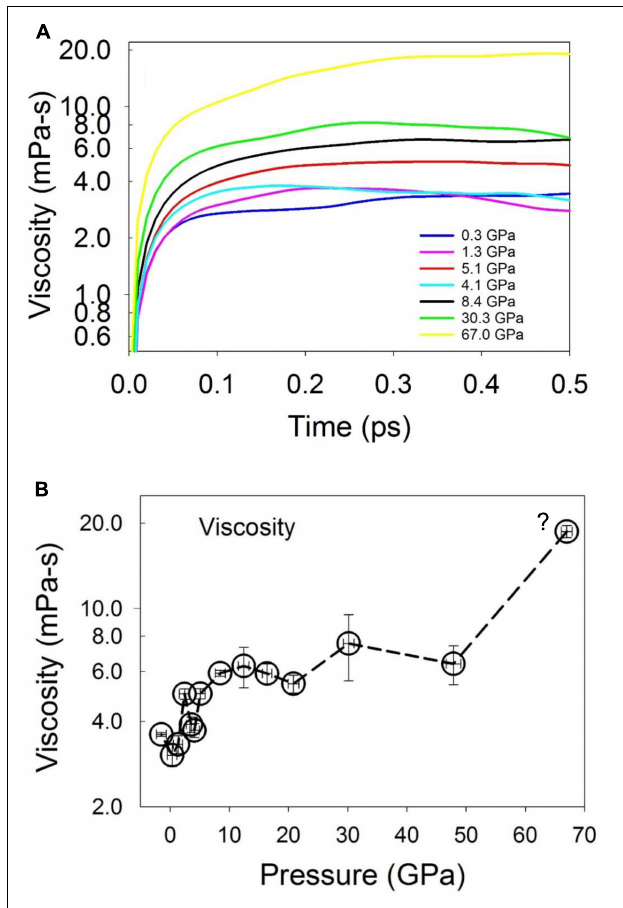
FIGURE 10 | Viscosity of Fe-Ni-C liquid at 1673 K. (A) Convergence of viscosity of the liquid as a function of time at selected pressures. (B) Viscosity at 1673 K as a function of pressure. The question mark in (B) indicates that the liquid may be in a metastable state. The error bar was estimated as the standard deviation over a short time scale after the integral reaches the